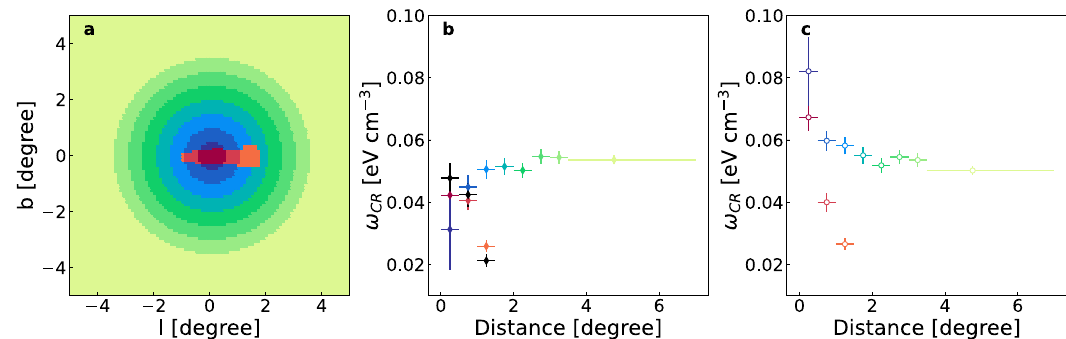
Fig. 2 The segment division of the GC region and the inferred CR densities distribution. a The segments, annuli centered on the GC with a width of 0.5° except for the last one, where CR densities are derived, in the CMZ and off-CMZ are marked in red to orange and blue to green, respectively. The same color code is used to show data points of CR densities in corresponding segments in ( b , c ). b CR densities distribution from fi ttings with the GCE. For segments outside the CMZ, the CR density is almost a constant. In the CMZ, the CR density declines quickly as the distance increases from the GC. These facts strongly suggest different physical origins of CRs within and outside the CMZ. CR densities in the CMZ, inferred from analysis with the CS map 29 , are shown with black points, which agree well with those derived from the fi tting with the Planck map. The error bars represent the 1 σ statistical uncertainties. c CR densities distribution from fi ttings without the GCE, for which the inferred CR densities near the GC were boosted compared with those shown in ( b ). The error bars represent the 1 σ statistical uncertainties. Source data are provided as a Source Data